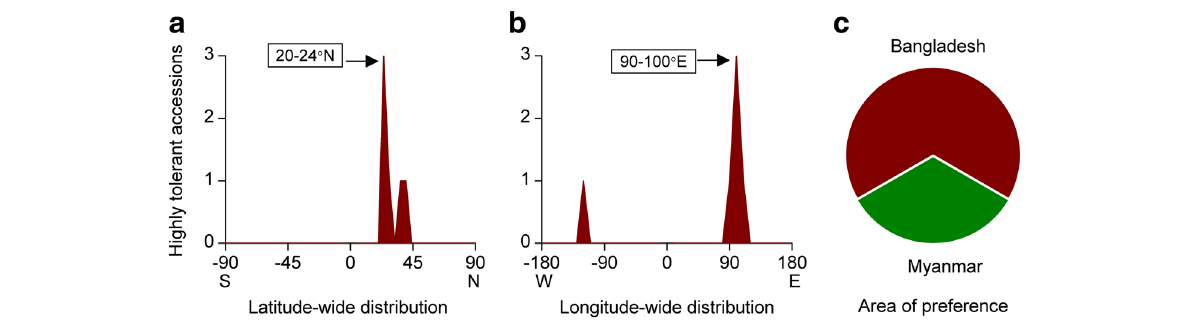
Fig. 7 Geographic distribution pattern of anaerobic germination (AG) tolerant rice accessions. a Latitude-wise distribution, b Longitude-wide distribution, c Area of preference